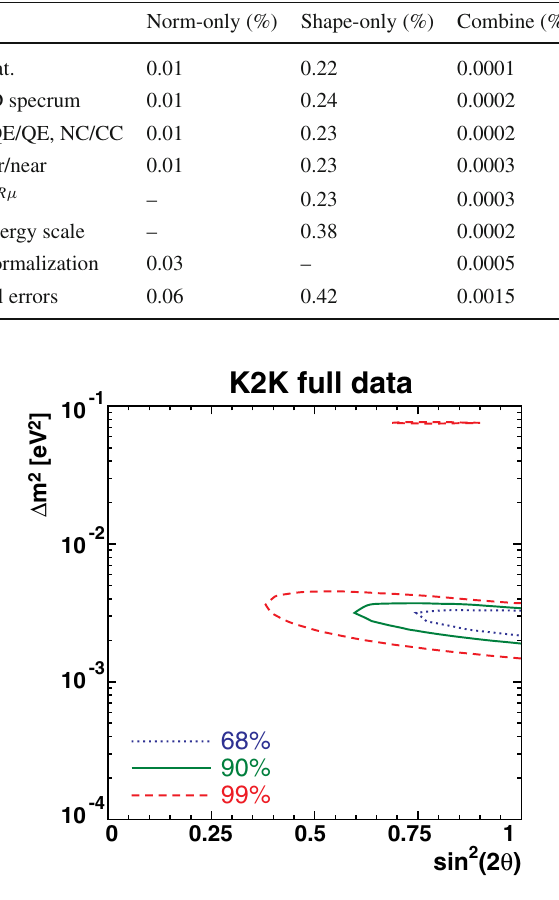
Fig. 33 Allowedregionsofoscillationparameters.Thehorizontalaxis shows sin 2 2 θ and the vertical axis shows Δ m 2 . Three contours corre- spond to the 68% (dotted line), 90% (solid line) and 99% (dashed line) CL. allowed regions, respectively sin 2 2 θ and Δ m 2 , with a slice at Δ m 2 = 2 . 8 × 10 − 3 eV 2